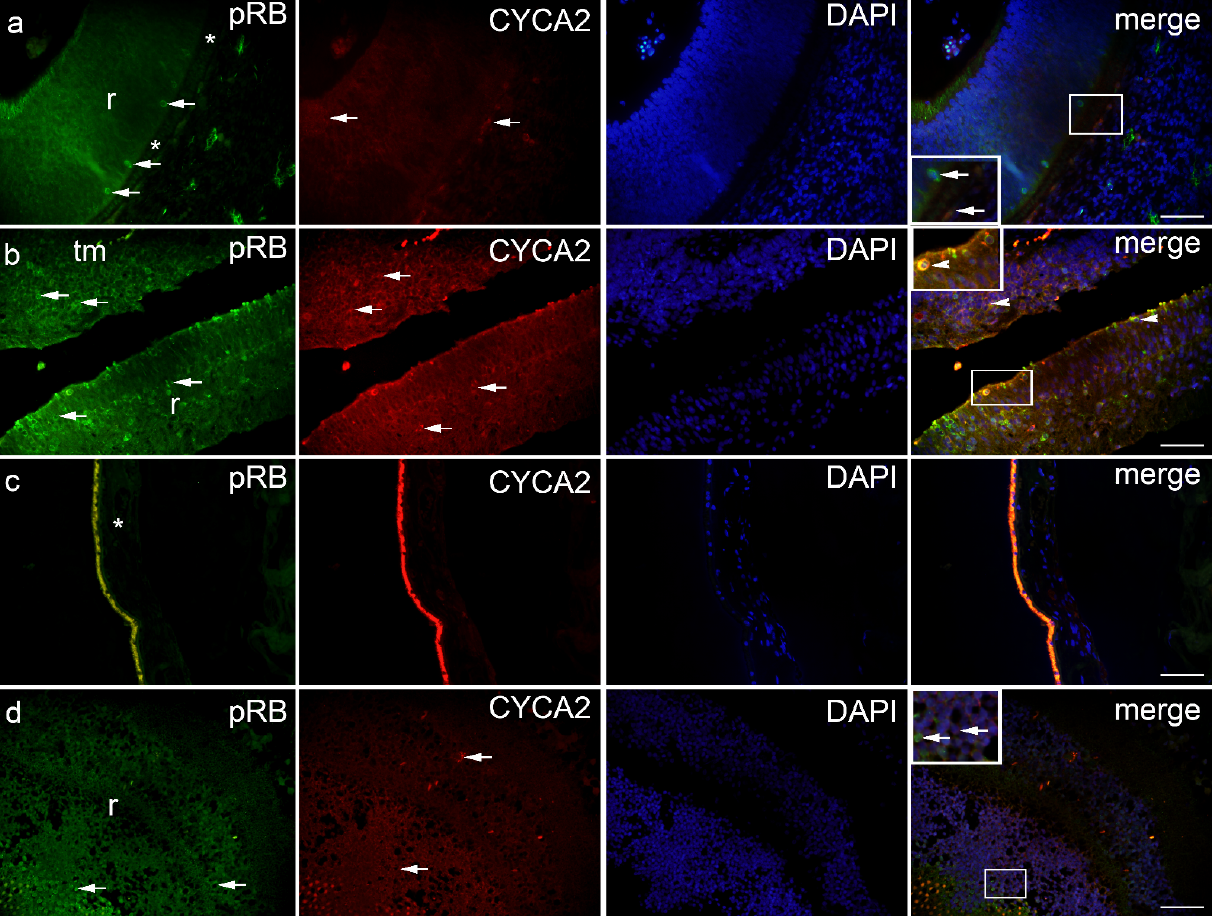
Figure 6. pRB and CYCA2 positive cells (arrows) can be seen in the eye section of an 8-week human embryo-8-w.HE ( a ), retinoblastoma-Rb ( b ), normal human eye-NHE ( c ) and epithelioid melanoma- EM ( d ); r—retina, *—choroidea, tm—tumor tissue. Co-localization of pRB and CYCA2 positive cells (arrowhead in the inset of magnification frame). Double immunofluorescence staining to pRB (first column), CYCA2 (second column), DAPI (third column), merge (fourth column). Magnification frames provide detail with positive cells (arrows) or co-localization (arrowheads). Scale bar 25 μ m.